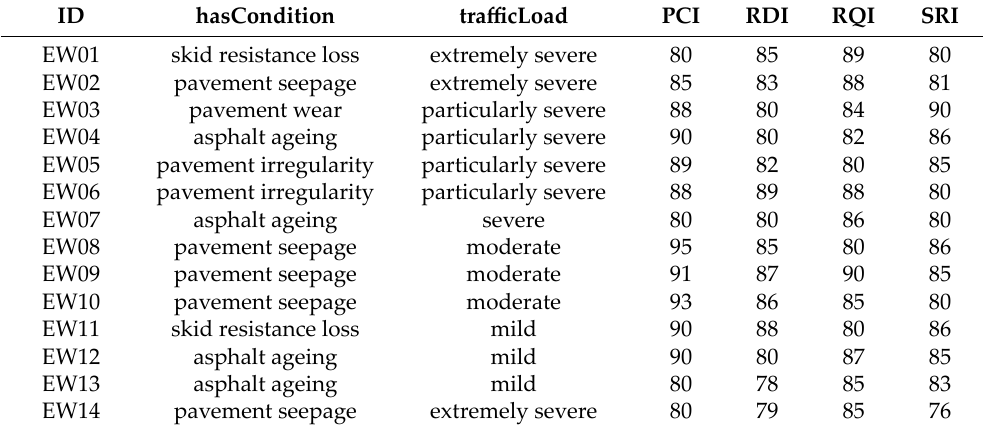
Table 10. Examples of urban